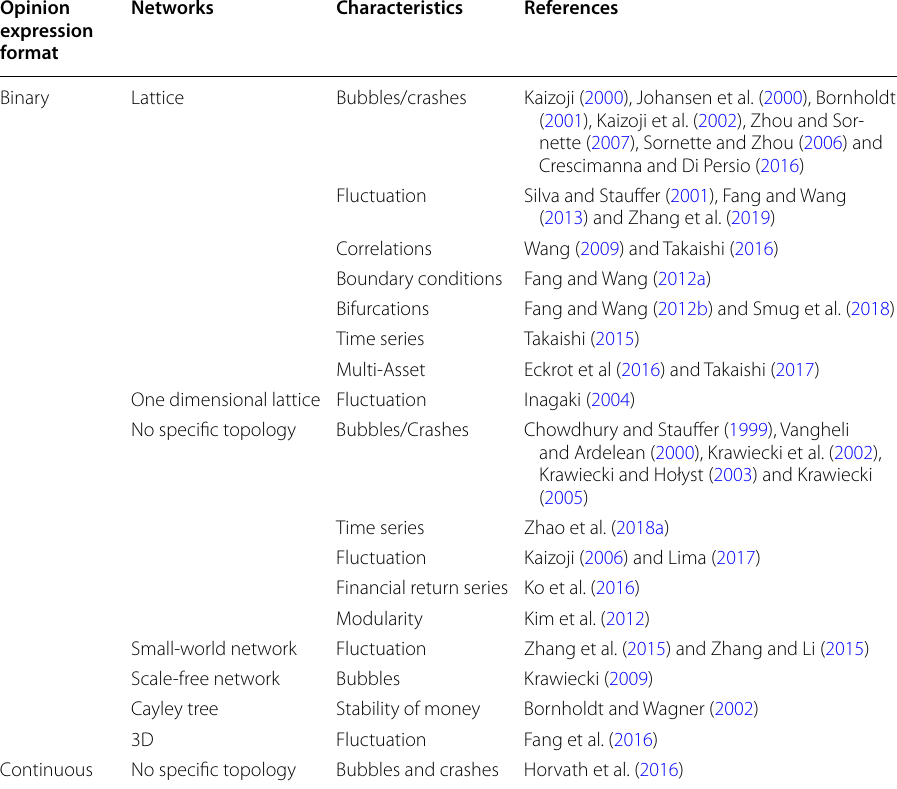
Table 1 The application of the Ising model in financial market Opinion